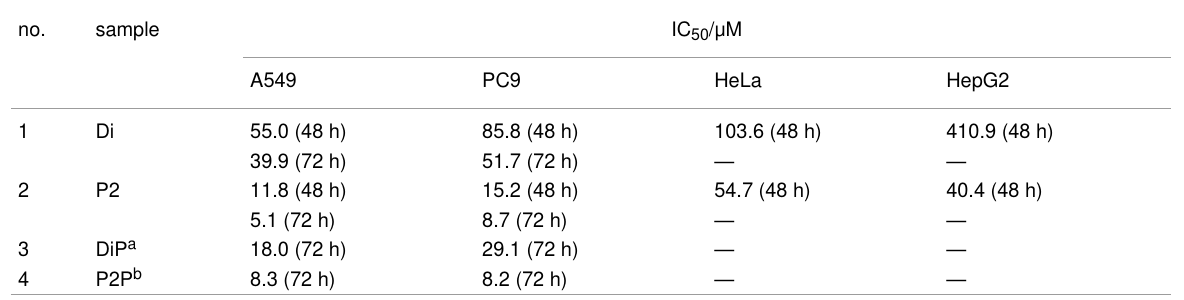
Table 1: The IC 50 values of diosgenin (Di), FZU-0021-194-P2 (P2) and their phytosomes against cancer cells by MTT assay. no.